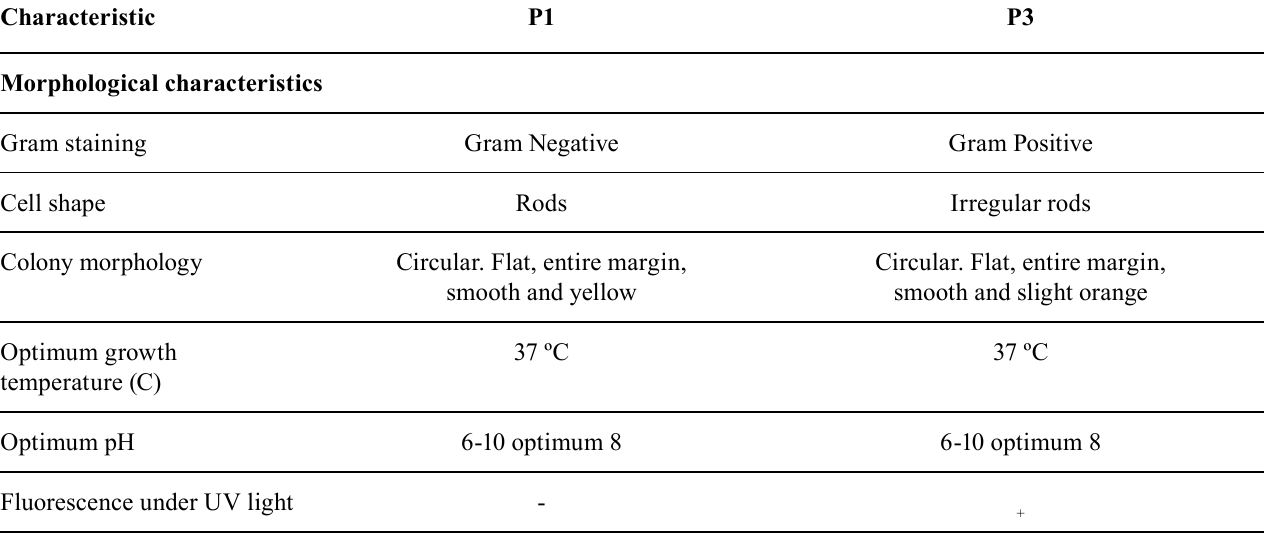
TABLE II – Morphological and Biochemical characterization of isolates Characteristic Morphological